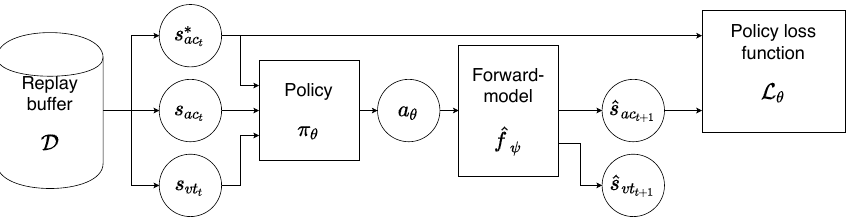
Figure 6. Computing the policy loss function using the